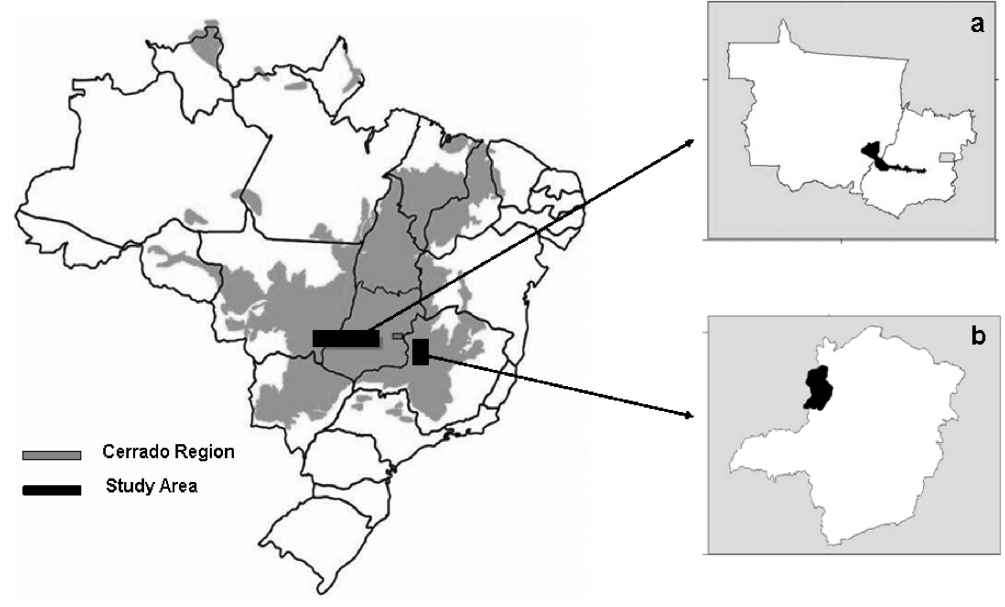
Fig. 1 – Cerrado region in Central Brazil and detail showing the study area: a) Goiás and Mato Grosso States; b) Minas Gerais State. (Adapted from Embrapa